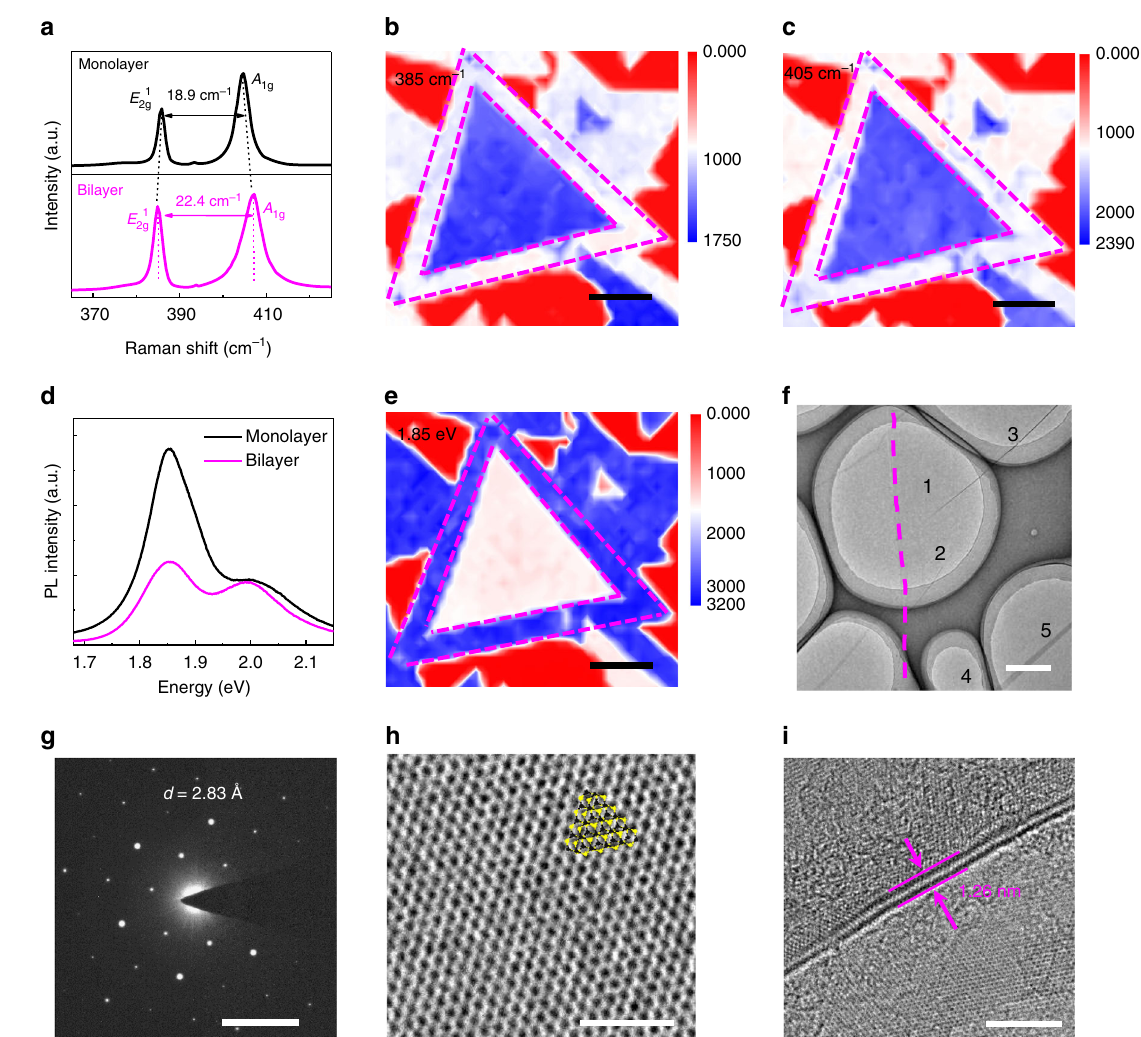
Fig. 2 Material imaging and crystal structure characterization. a Raman spectra of CVD monolayer (black line) and bilayer MoS 2 (magenta line). For monolayer one, the E 2g 1 peak is at 385.8 cm − 1 and the A 1g peak is at 404.7 cm − 1 , corresponding to a delta of 18.9 cm − 1 . For bilayer MoS 2 , the E 2g 1 peak is at 384.8 cm − 1 and the A 1g peak is at 407.2 cm − 1 , corresponding to a delta of 22.4 cm − 1 . b , c Raman spectroscopy maps of the peaks at 385 cm − 1